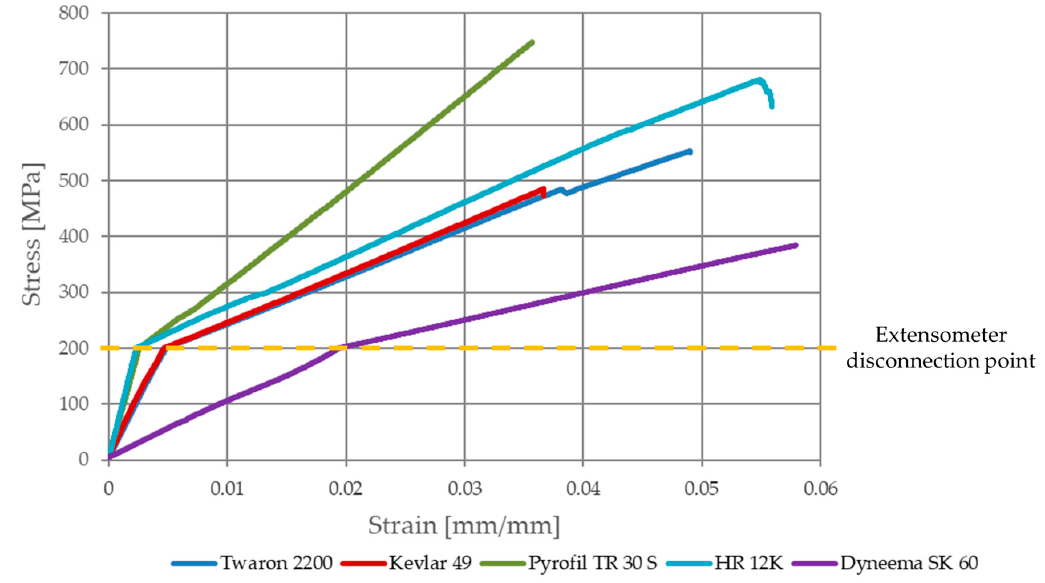
Figure 11. Stress–strain curves of the epoxy composites with various reinforcing materials.